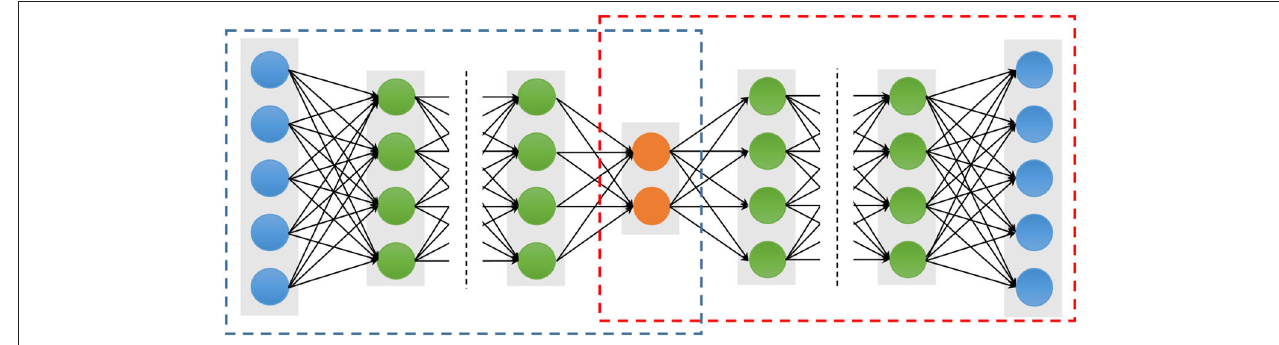
FIGURE 2 | Architectures of a stacked auto-encoder. The blue and red dotted boxes represent the encoding and decoding stage, respectively. The blue solid circles are the input and output units, which have the same number nodes. The orange solid circles represent the latent representation, and the green solid circles represent any hidden layers.